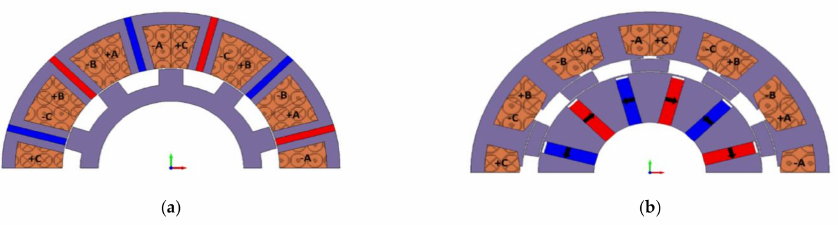
Figure 10. PM-flux switching machine topologies. ( a ) Conventional FSM, ( b ) PM Partitioned stator